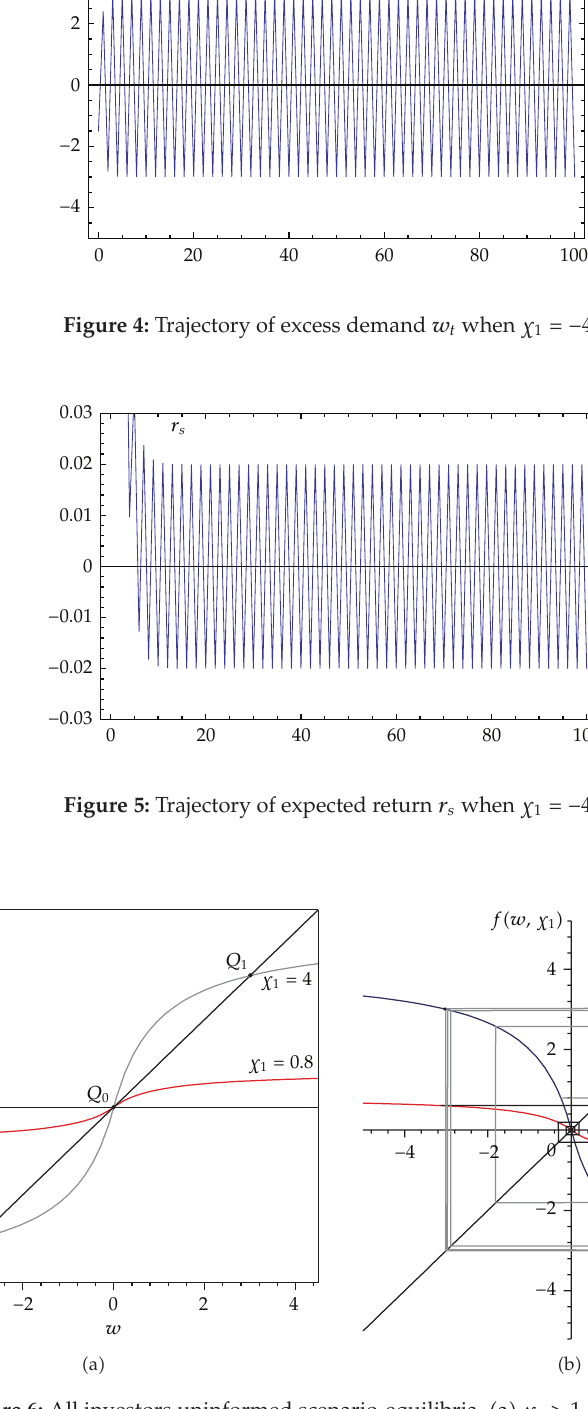
Figure 6: All investors uninformed scenario-equilibria. (cid:3) a (cid:6) χ 1 > 1, (cid:3) b (cid:6) χ 1 < −